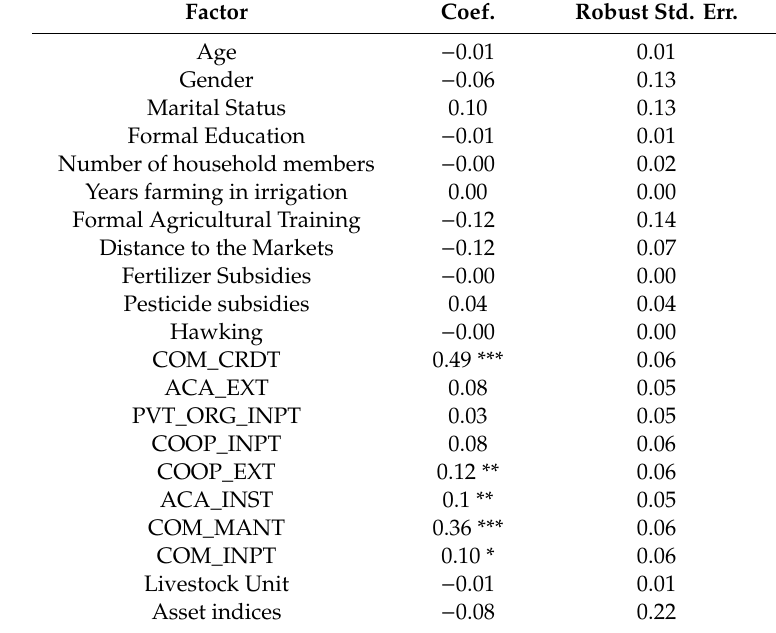
Table 8. Ordinary least square (OLS)results on the relationship between the yield of sweet potato and institutional factors, social factors, and managerial